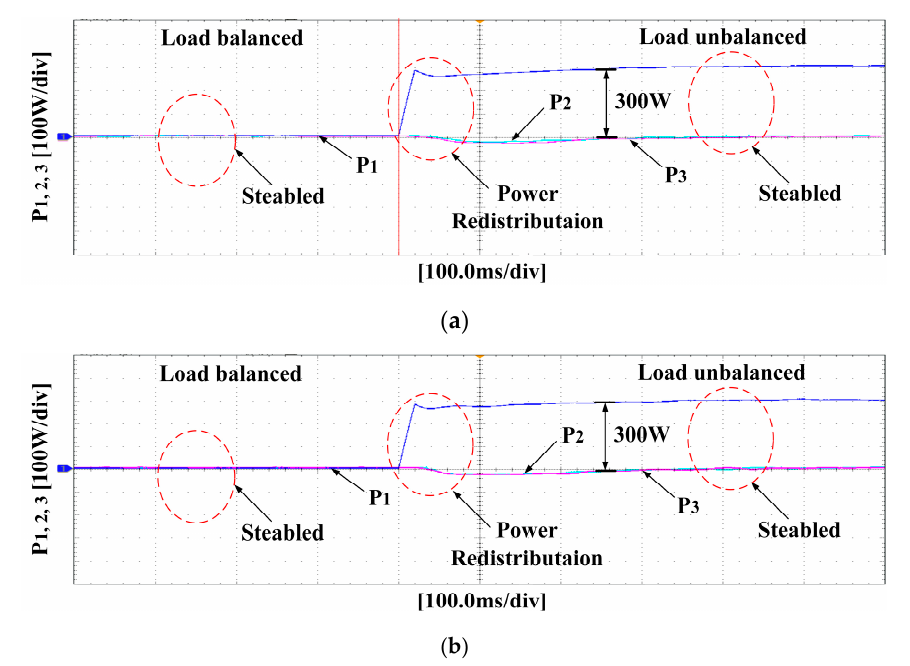
Figure 18. Experimental waveforms of the dc-link voltage of the CHBR modules under load variation by use of ( a ) the proposed control strategy and ( b ) the conventional control strategy.